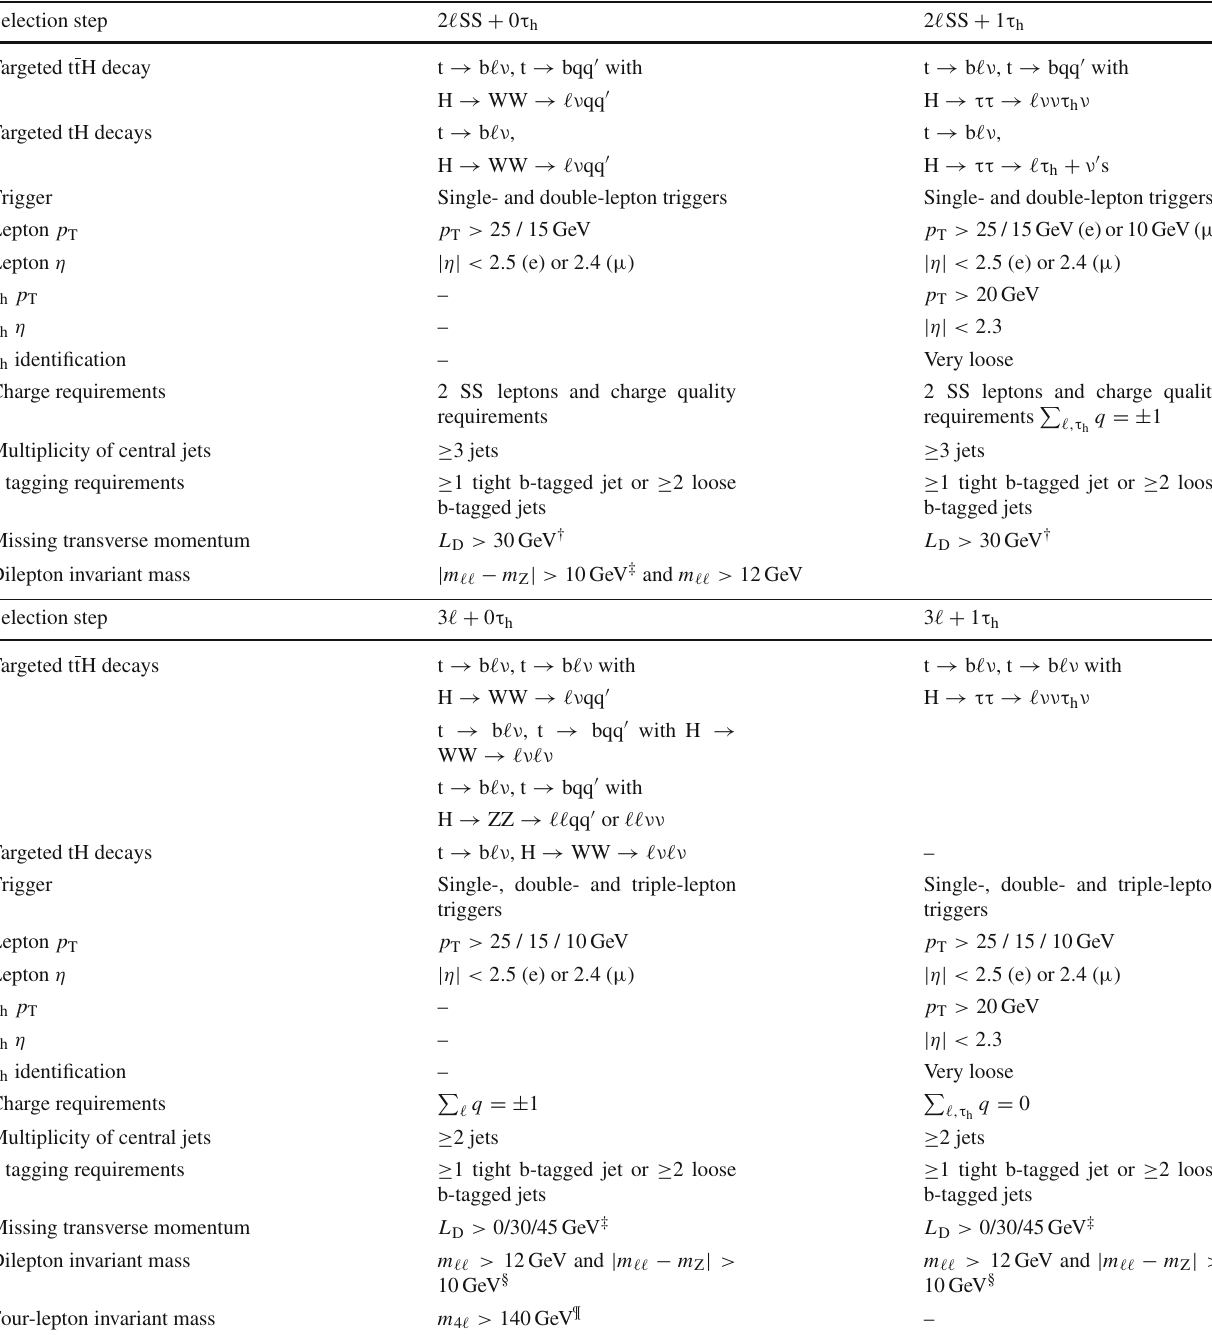
Table 2 Event selections applied in the 2 (cid:4) SS + 0 τ h , 2 (cid:4) SS + 1 τ h , 3 (cid:4) + 0 τ h , and 3 (cid:4) + 1 τ h channels. The p T thresholds applied to the lepton of highest, second-highest, and third-highest p T are separated by slashes. The symbol “–” indicates that no requirement is applied Selection step 2 (cid:4) SS + 0 τ